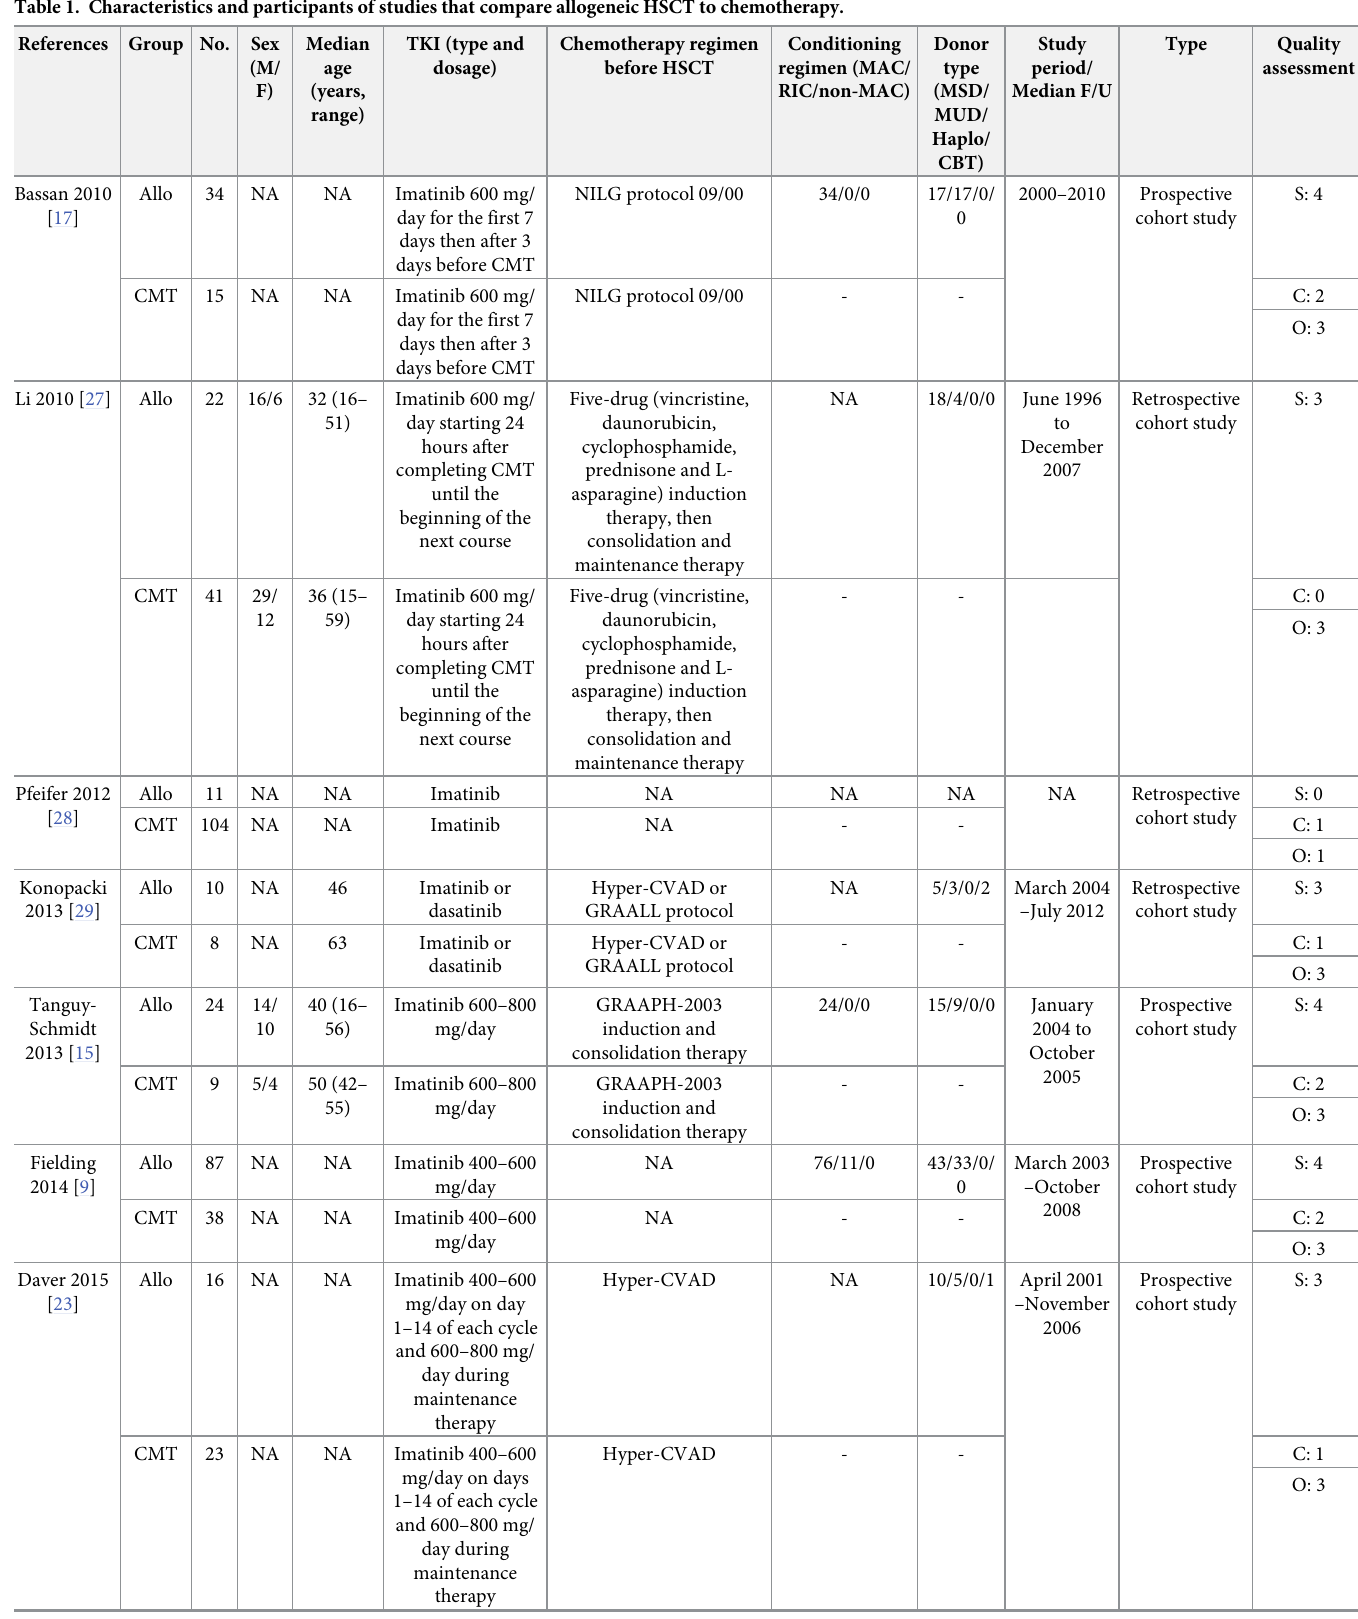
Table 1. Characteristics and participants of studies that compare allogeneic HSCT to chemotherapy. References Group No. Sex